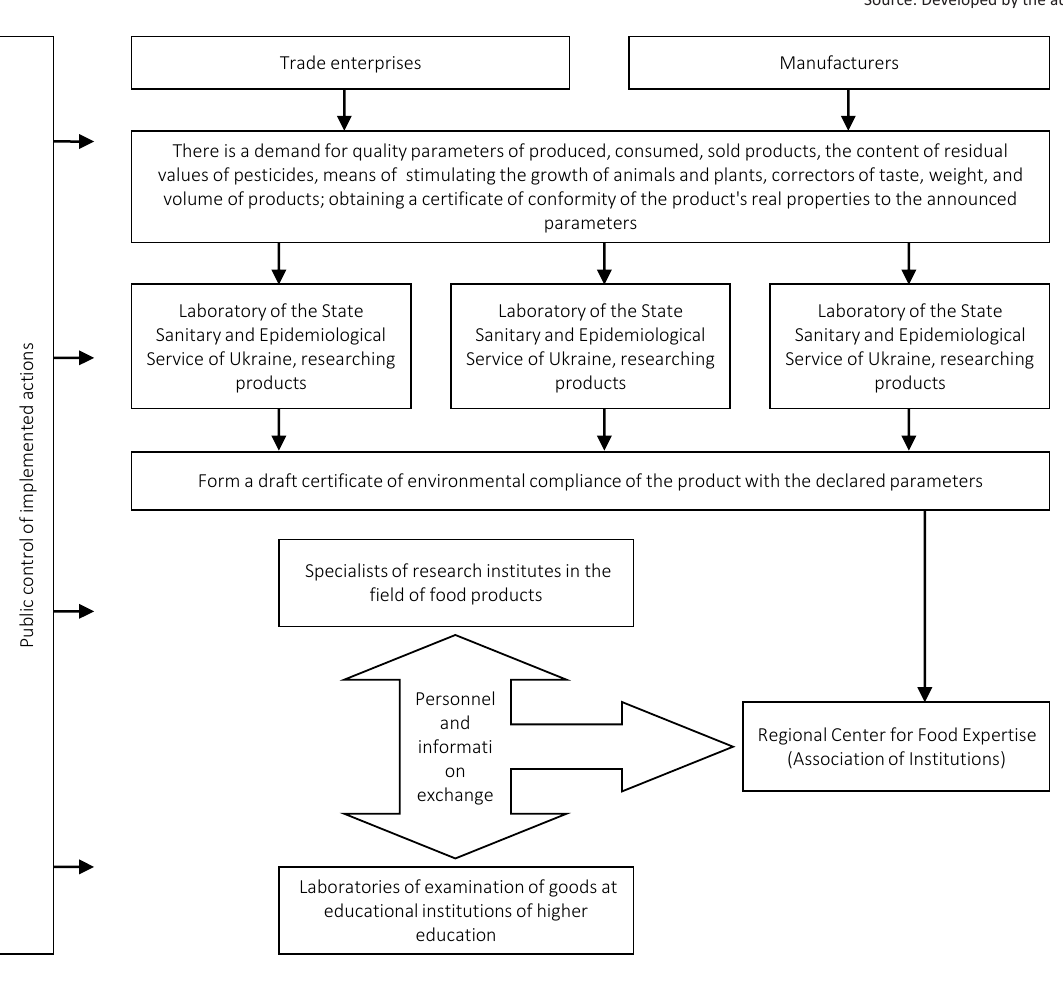
Figure 5. Scheme of the regional center for examination of food products ecological